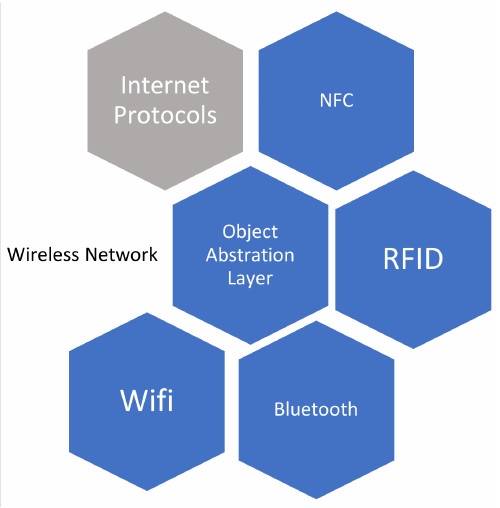
Figure 6. Communication